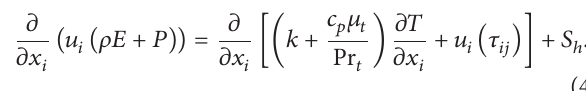
Table 2: Constants of RNG 𝑘 - 𝜀